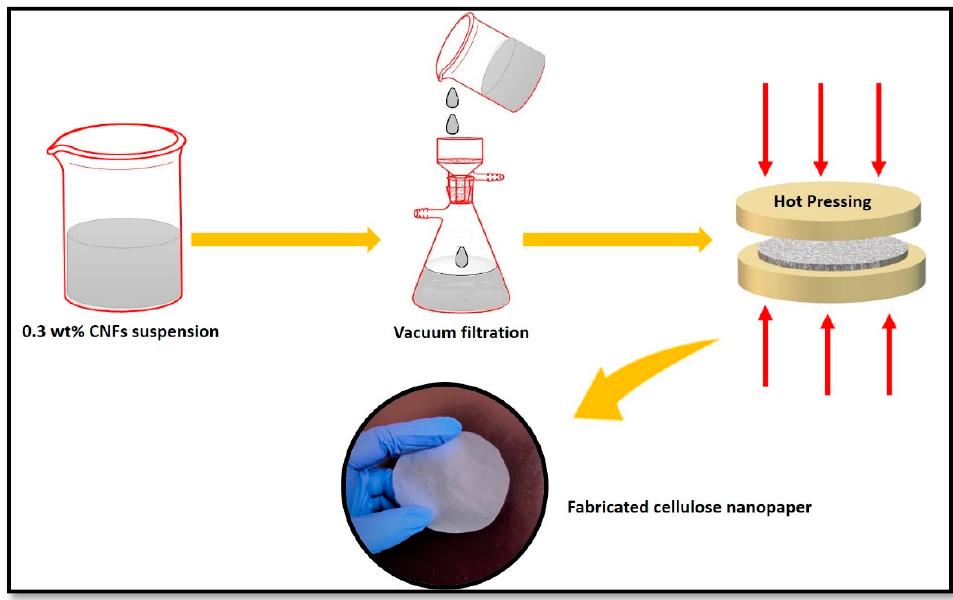
Figure 8. Diagram depicting the fabrication of cellulose nanopaper.